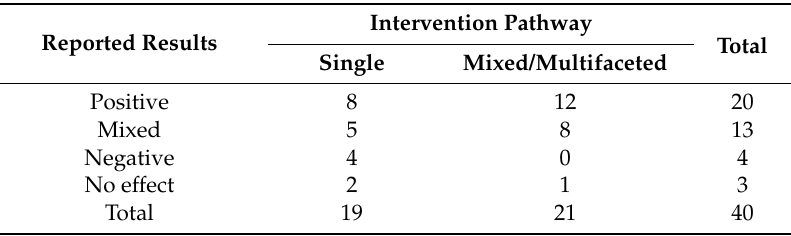
Table 6. Results, by intervention